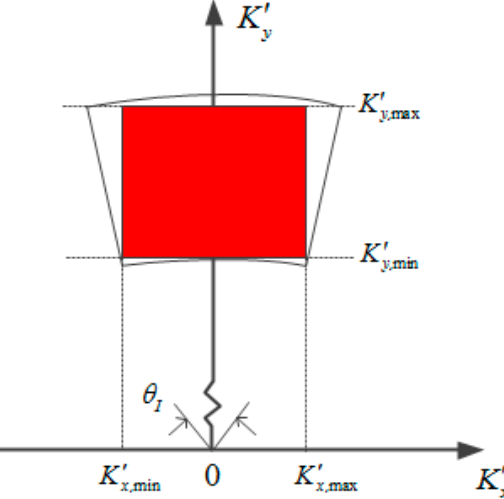
Figure 5. The 2D distribution of target’s wavenumber spectrum. According to Equation (16), the azimuth resolution is inversely proportional to az- imuth integration angle. The relationship between the azimuth integration angle and resolution in Ku, Ka, W and THz bands is shown in Figure 6. A given azimuth resolution (high) can be achieved at a smaller azimuth integration angle if the carrier frequency is higher. For PFA, based on a small synthetic aperture angle assumption, we can hardly use low carrier frequency for high resolution imaging.